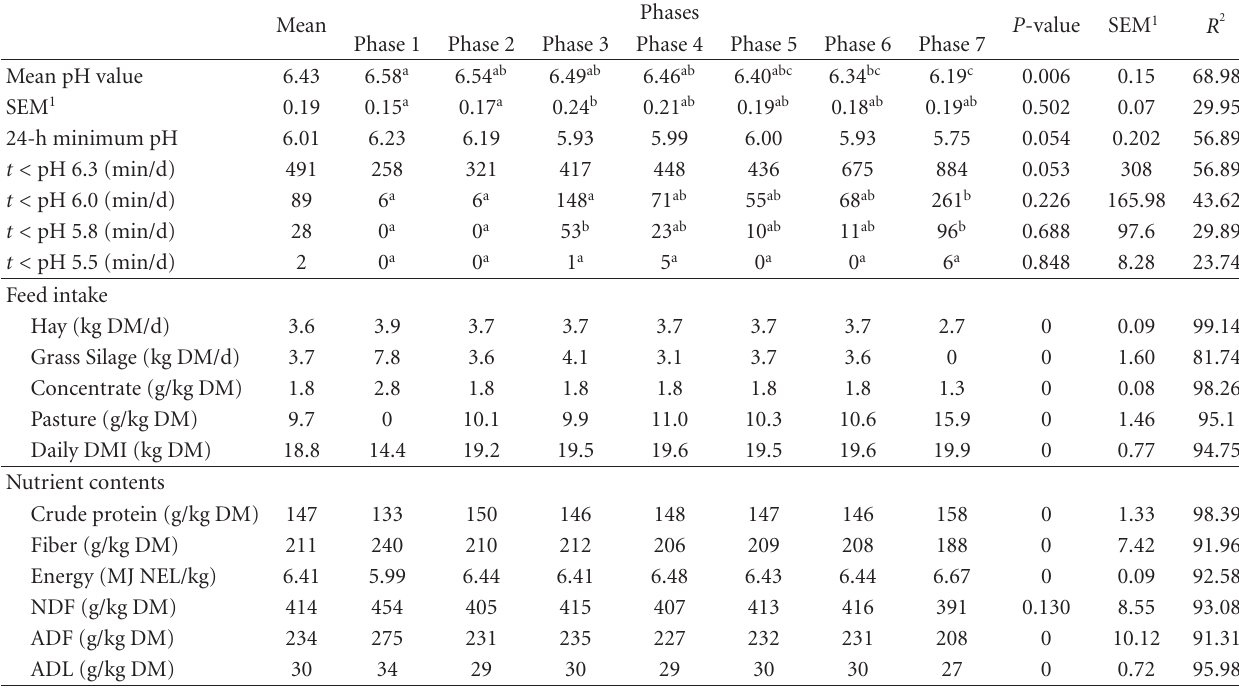
significantly ( P < 0 . 05) decreased in all 6 cows. Mean